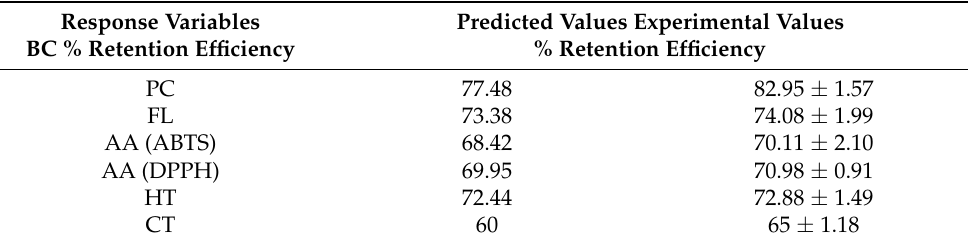
Table 4. Experimental and predicted values for all studied variables, for SPI microencapsulated muicle leaves extract obtained with the optimum operating conditions (2 3 factorial